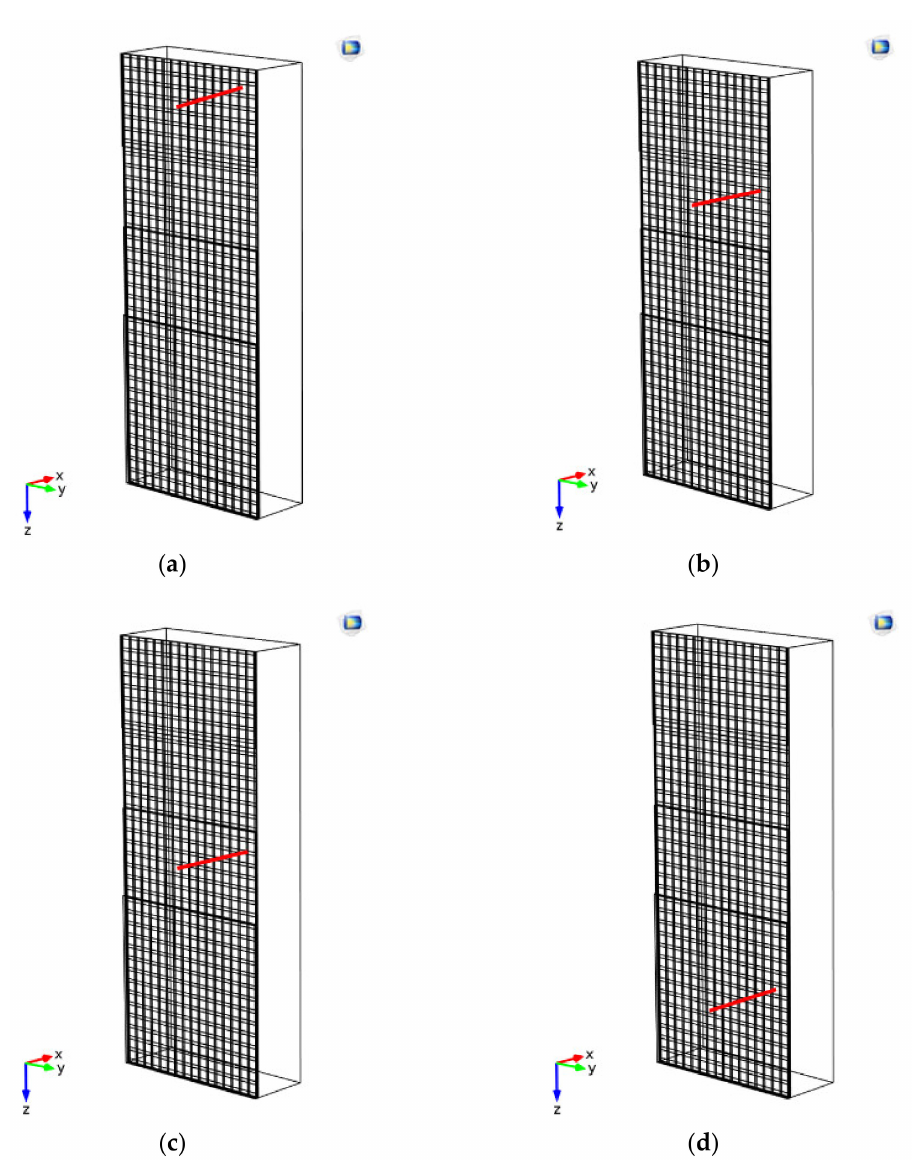
Figure 7. Determining in-depth temperature distributions (see red segments): ( a ) cement mortar (upper position), ( b ) cement milk, ( c ) cement mortar (lower position), ( d ) hemp